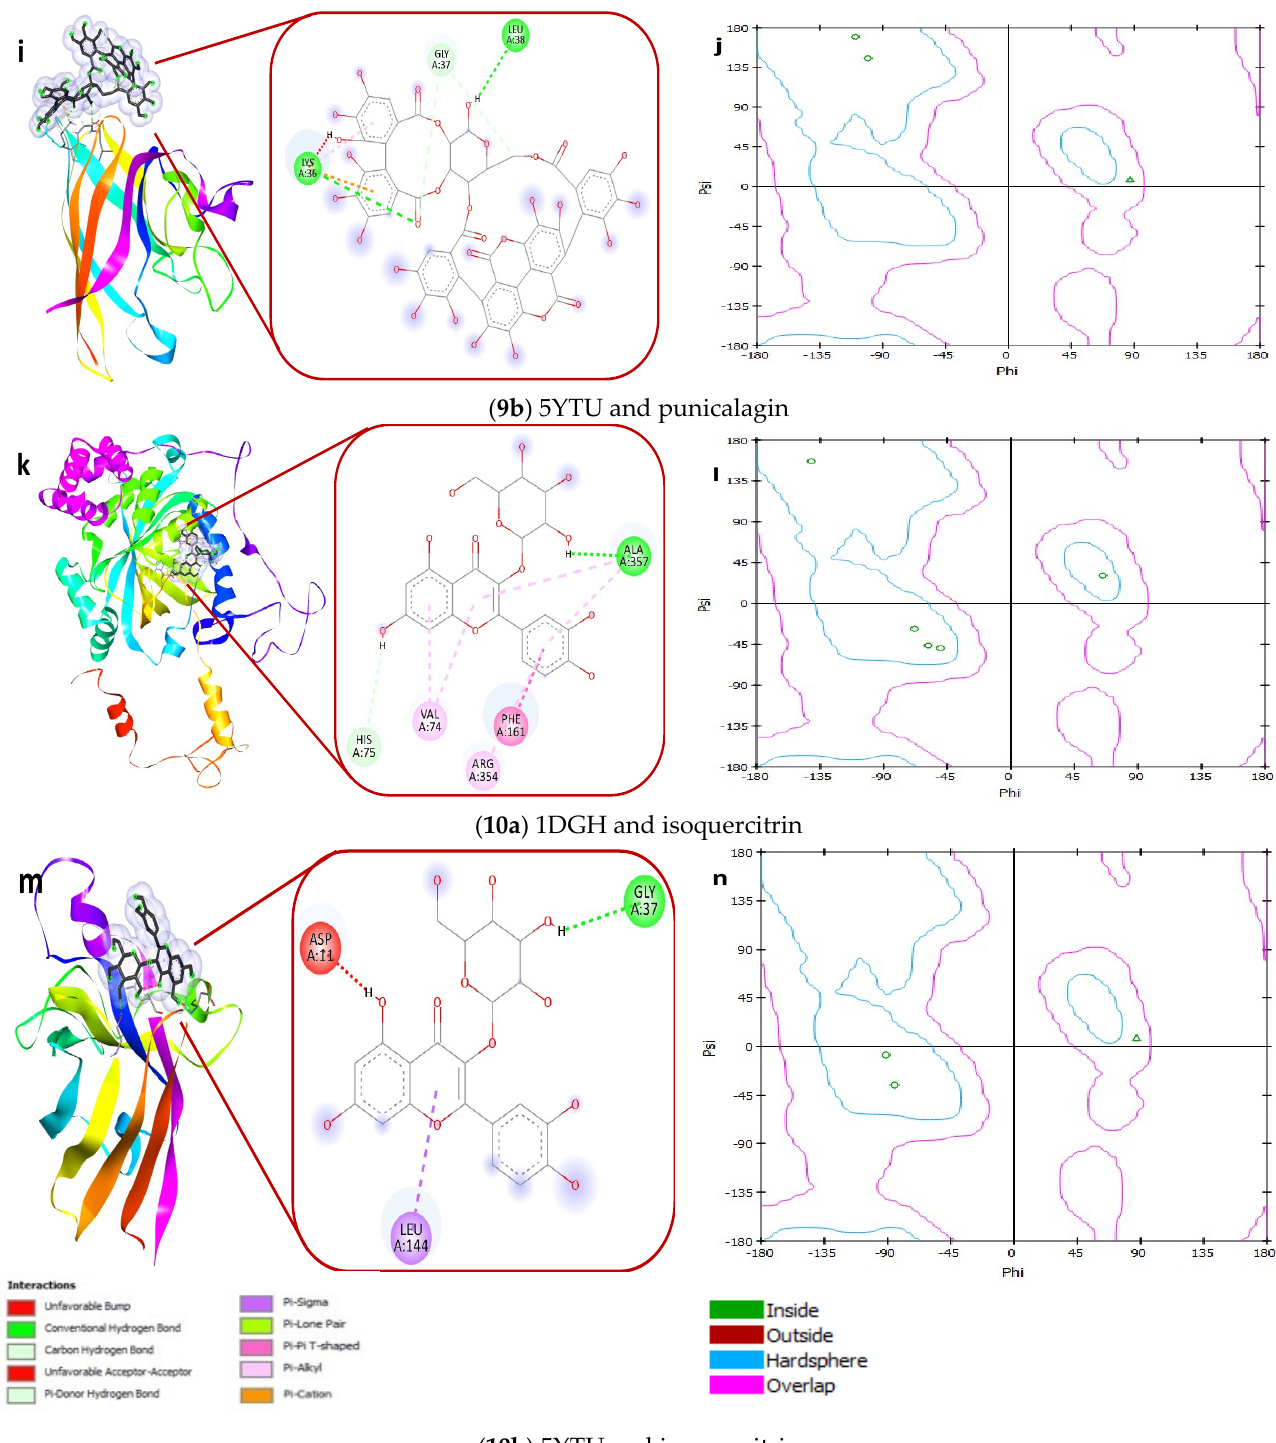
Figure 12. The molecular docking studies of antioxidant enzymes catalase (1DGH) and superoxide dismutase (5YTU) with active constituents of Ajwa date fruit with ligand ( 1 ) 3,3’-Di-O-methylellagic acid ( A , C ); ligand ( 2 ) rhamnetin ( E , G ); ligand ( 3 ) caffeic acid ( I , K ), ligand ( 4 ) ferulic acid ( M , O ), ligand ( 5 ) quercetin-rutinoside ( Q , S ); ligand ( 6 ) 6”’-malonylicariin ( U , W ), ligand ( 7 ) 4-hydroxybenzoic acid ( Y , a ), ligand ( 8 ) phytol ( c , e ); ligand ( 9 ) punicalagin ( g , i ); ligand ( 10 ) isoquercitrin ( k , m ) and the Ramachandran plot of respective interactions are provided with each ligand-protein interaction ( B , D , F , H , J , L , N , P , R , T , V , X , Z , b , d , f , h , j , l and n ).